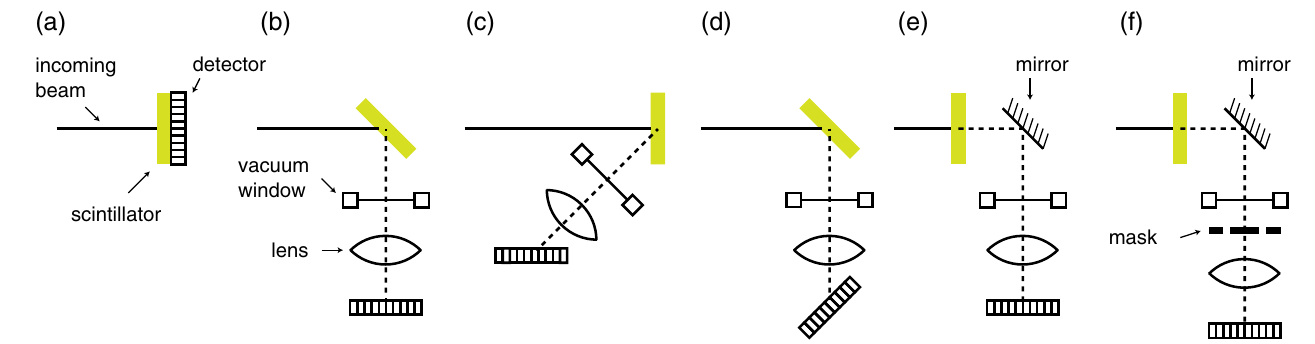
FIG. 1. Commonly used layouts to image fluorescent light onto a detector. (a) Direct detection of the light, (b) and (c) imaging the light through a vacuum window, (d) observing the Scheimpflug imaging geometry, (e) using an additional in-vacuum mirror, and (f) with an additional mask to block coherent transition